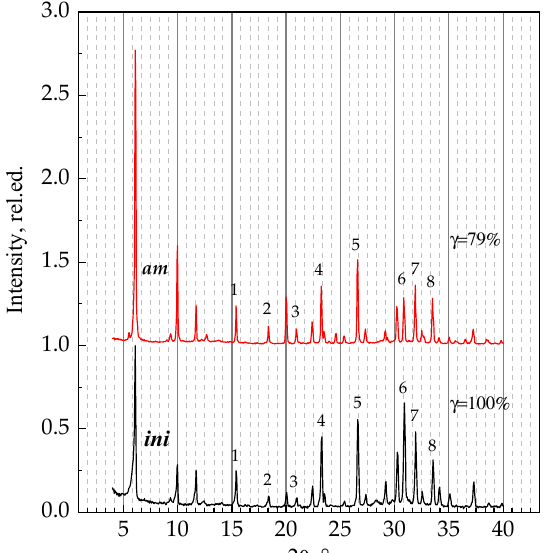
Figure 2. Powder X-ray diffraction patterns of the ini and am samples. Numbers correspond to reflexes characteristic for the FAU structure, namely (331)—1, (511), (333)—2, (440)—3, (533)—4, (642)—5, (822), (660)—6, (555), (751)—7, (664)—8. N 2 adsorption isotherms at − 196 °C for samples ini- 200 , ini- 300 , am- 200 and am- 300